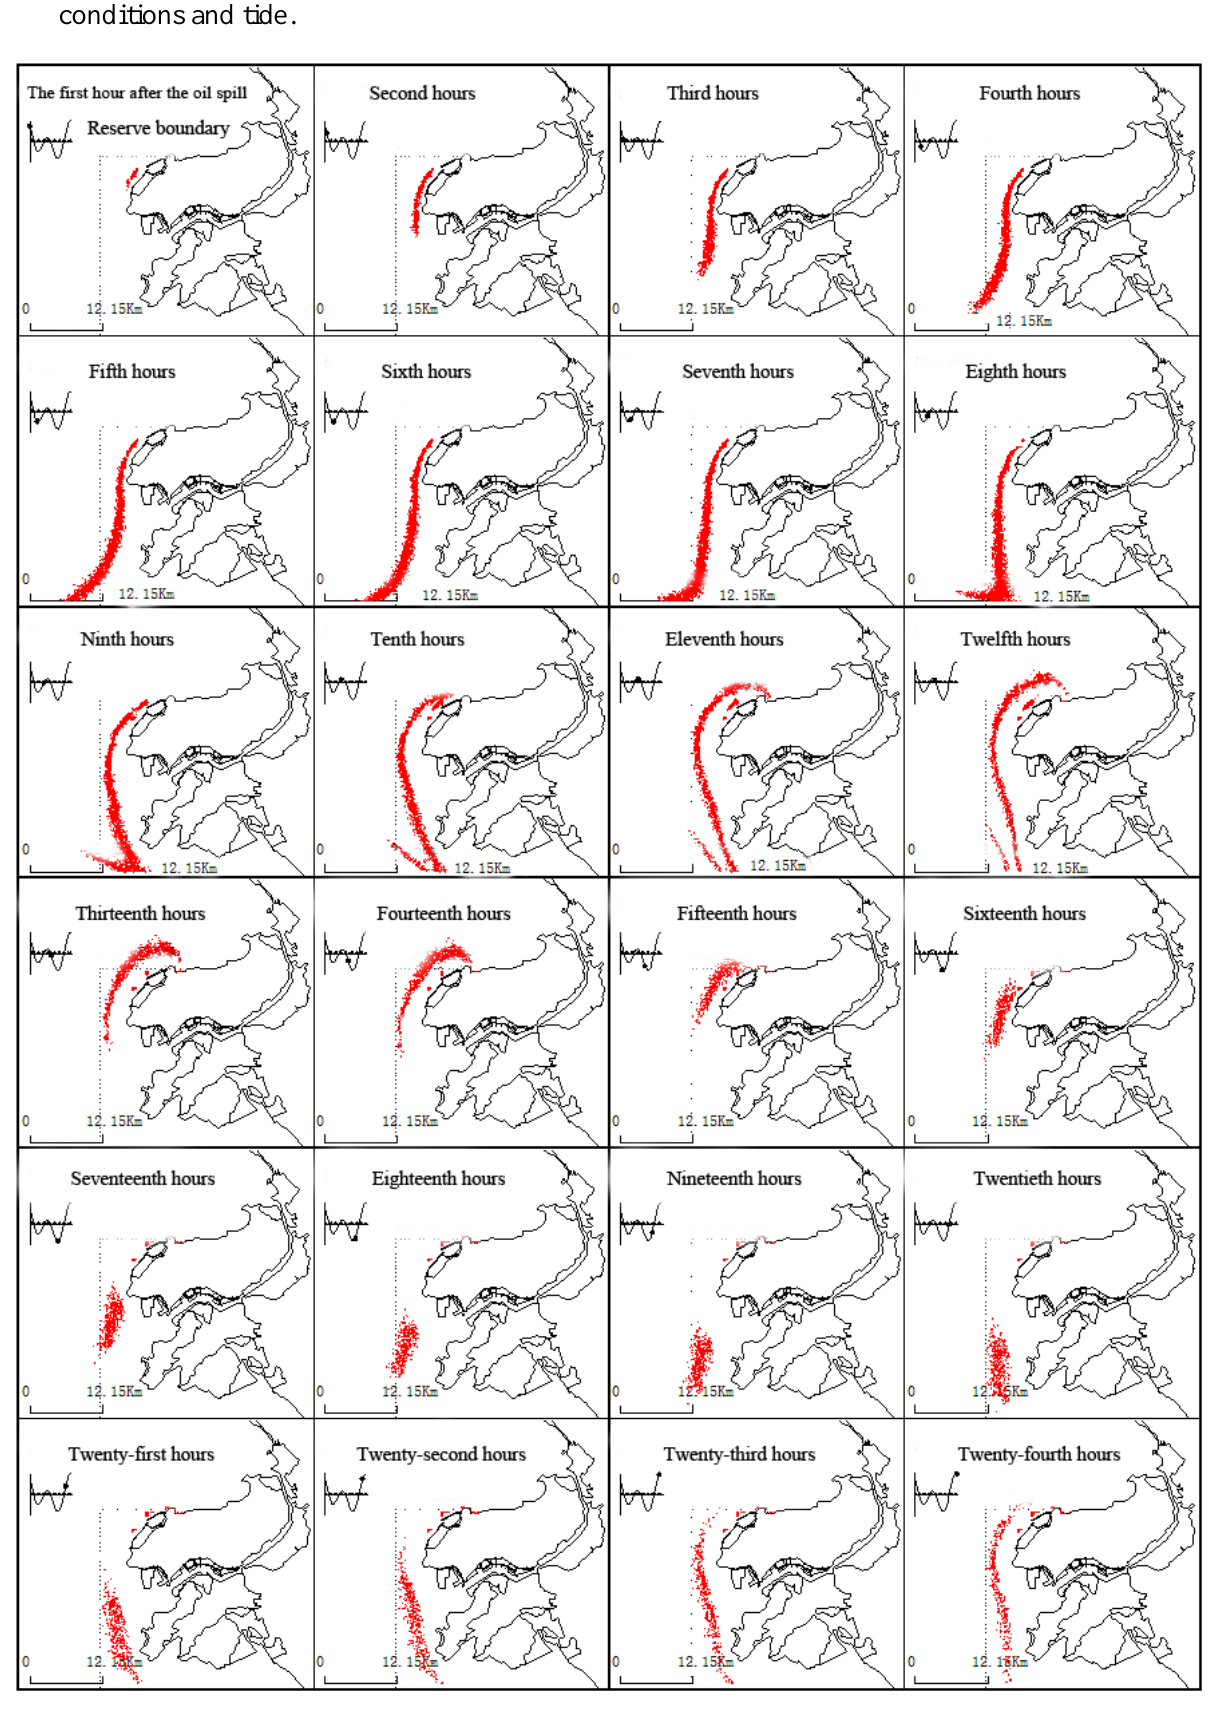
Figure 2. The dynamic changes of the oil film under continuous drift and NNE wind conditions and